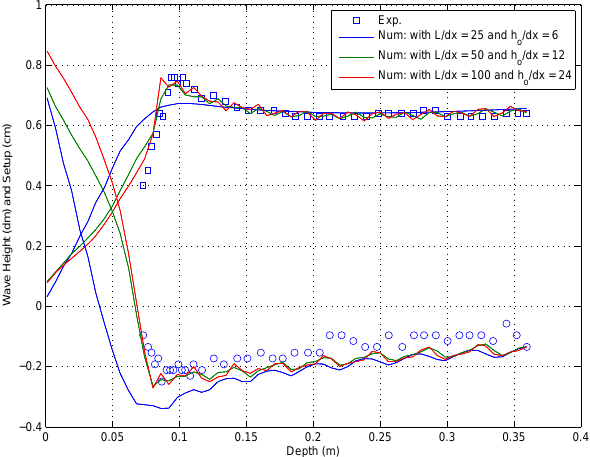
Fig. A5. Computed and measured wave heights and setup for the Hansen and Svendsen case A11012 ( kh o = 1 . 58, H/h o = 0 .